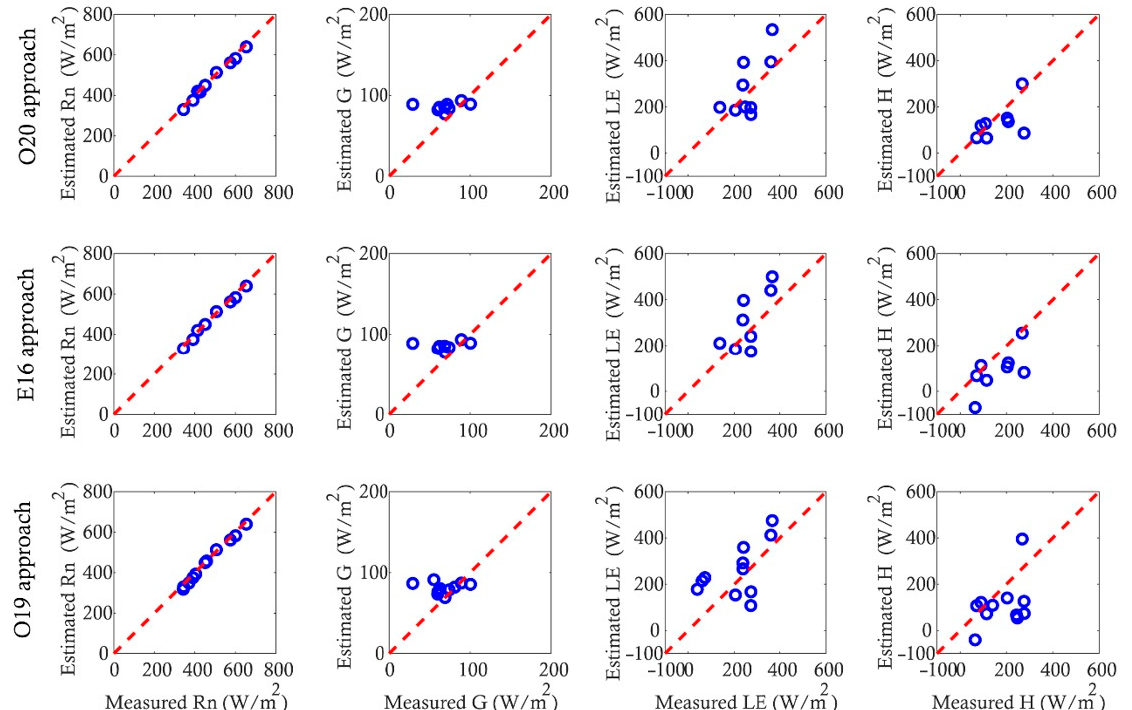
Figure 7. Scatterplot of simulated versus observed Rn, G, LE, and H using the three approaches at the Sidi Rahal site.